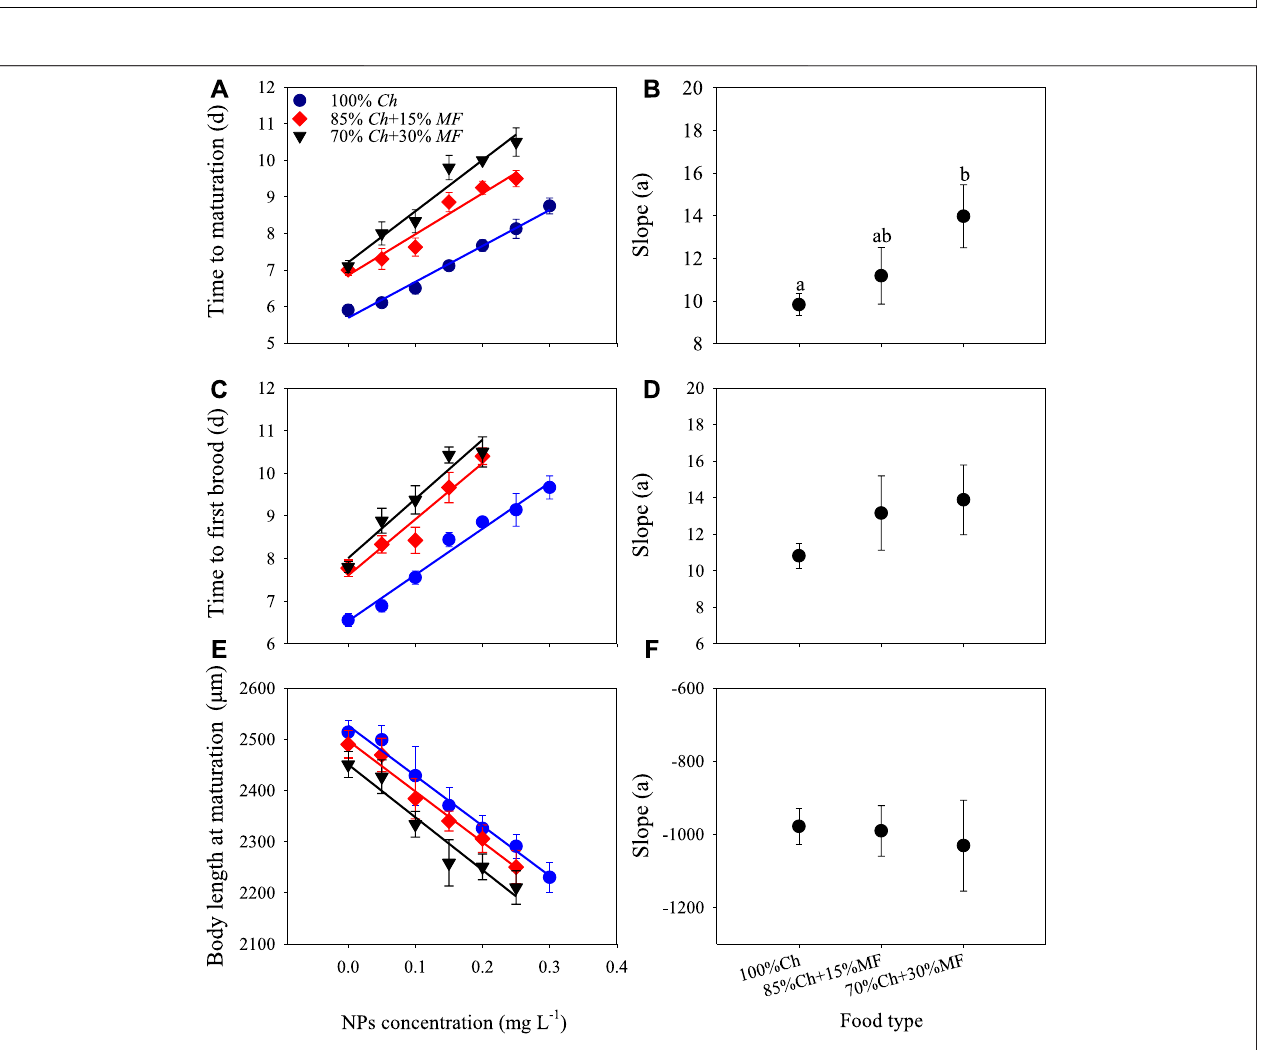
Frontiers in Environmental Science |